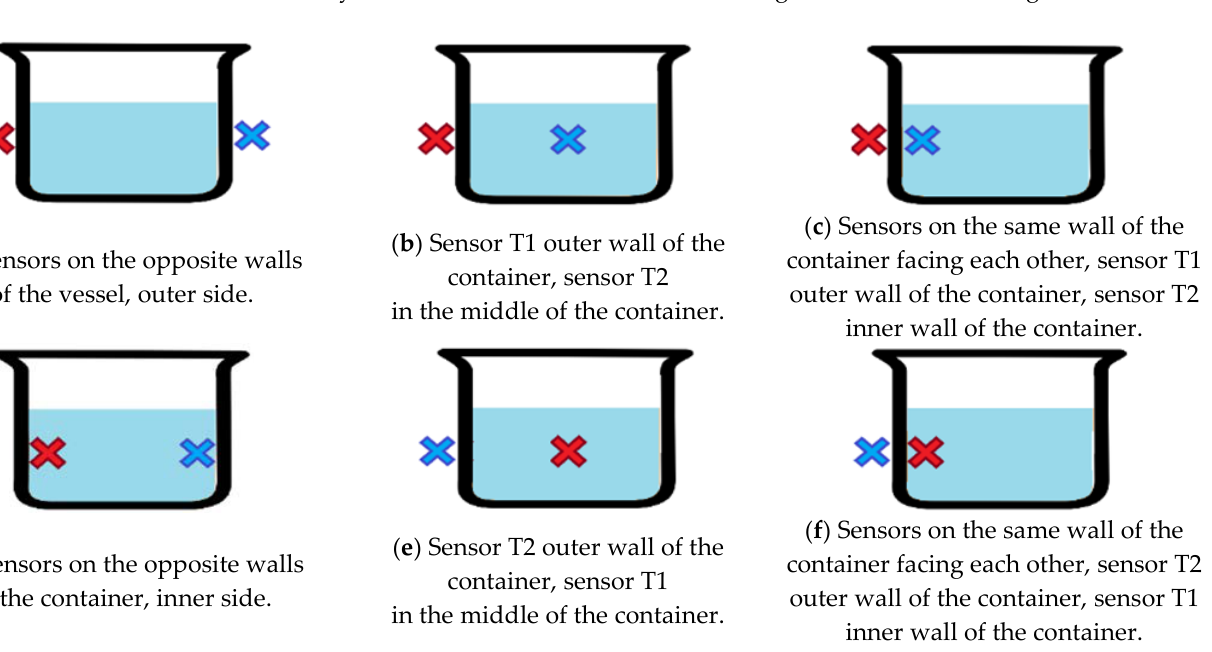
Figure 1. Schematic cases for different thermodynamic sensor configurations. The crosses show the position of the individual TDS sensors (the red cross indicates the T1 sensor, the blue cross indicates the T2 sensor) in relation to the measuring container with water.